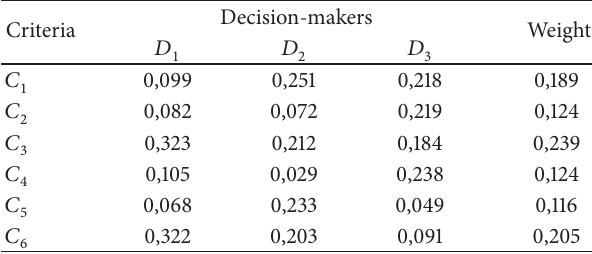
Table 6: The criteria weights attributed by